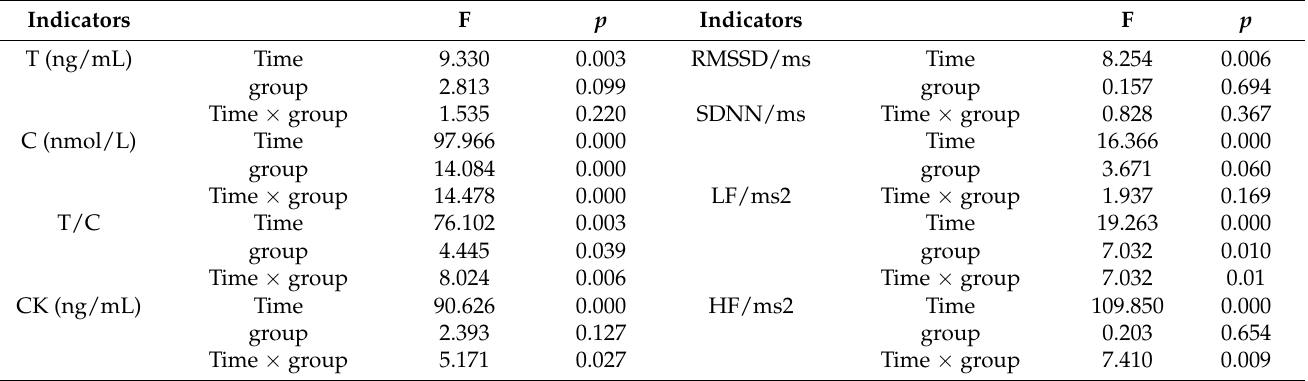
Table 3. Main effect and interactive effects of blood markers and HRV indicators after tPCS